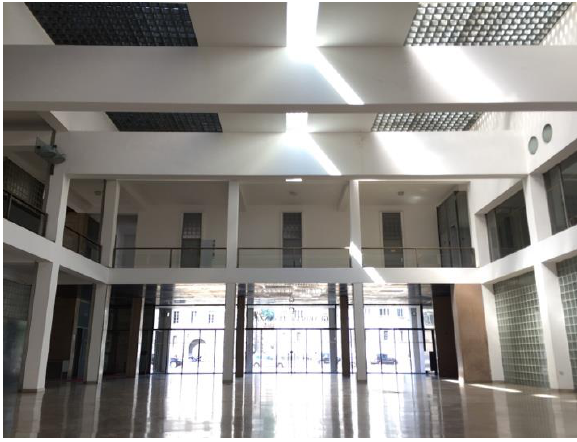
Figure 2. Salone delle Adunate (Authors’ capture, 2016) The second floor follows the distribution system of the first; the difference is that the gallery opens onto the roof of the internal atrium, characterized by a walkway that crosses it in the middle. used as offices, administration and library (Figure 3).